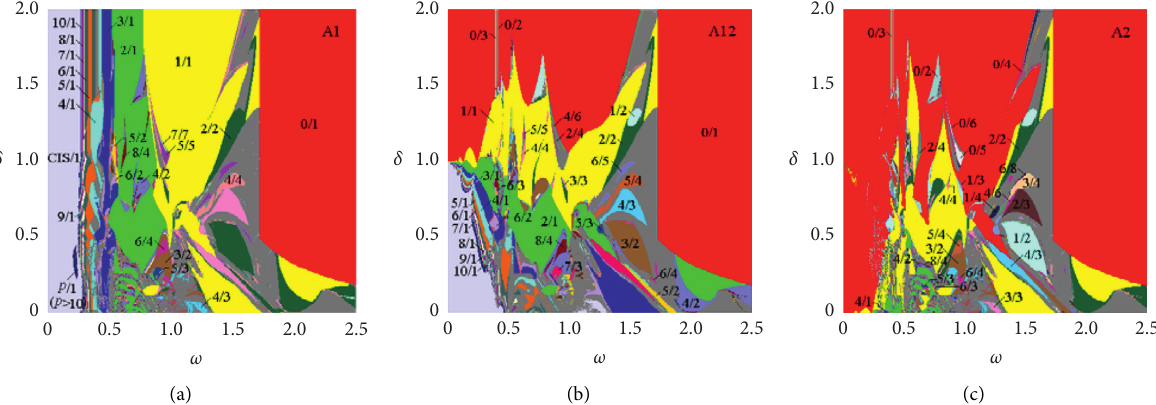
� δ � 0 . 5. (a) Constraint A 1 ; 1 2